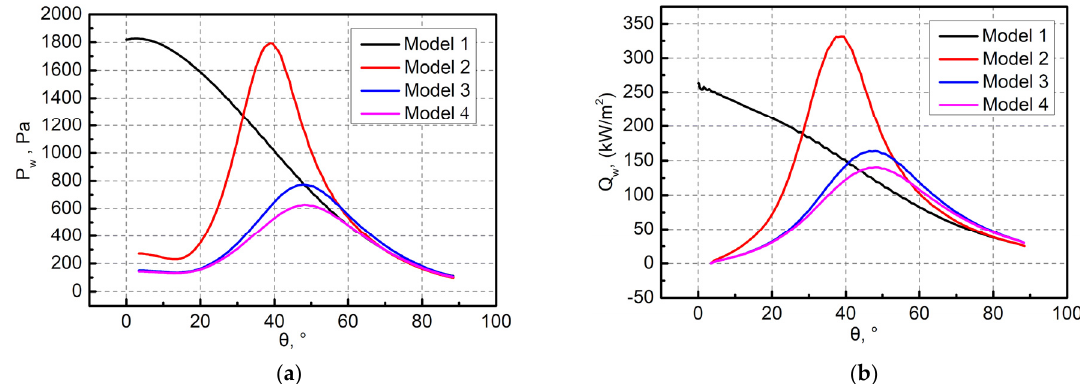
Figure 10. Initial pressure and heat flux of forebody: ( a ) pressure; ( b ) heat flux. Table 6. Drag coefficient and peak heat flux of